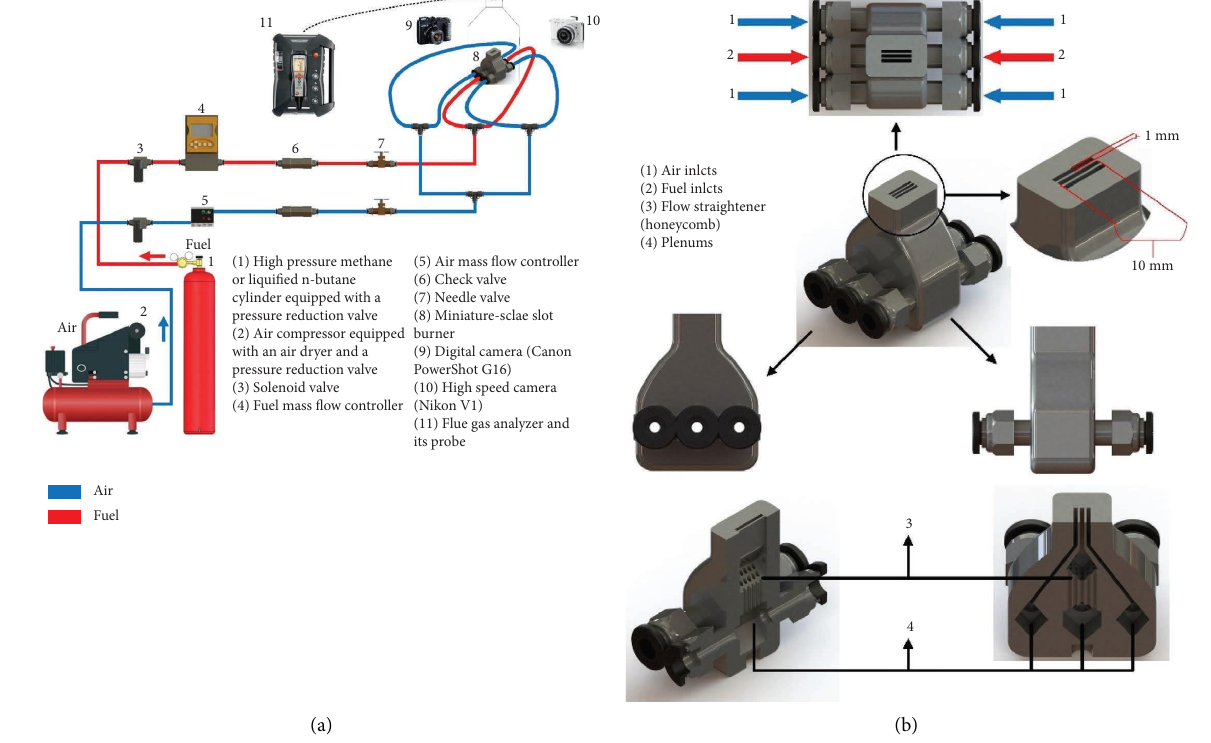
Figure 1: (a) Experimental setup and fow delivery system; (b) micro-slot